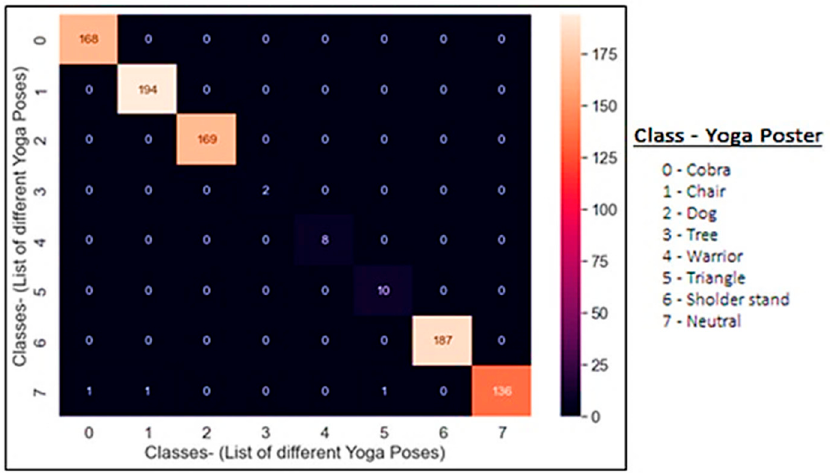
Figure 15. Confusion matrix of Y_PN-MSSD model with predicted labels on x-axis and true labels on y-axis. Table 2. Hyperparameters of the proposed Y_PN-MSSD model.